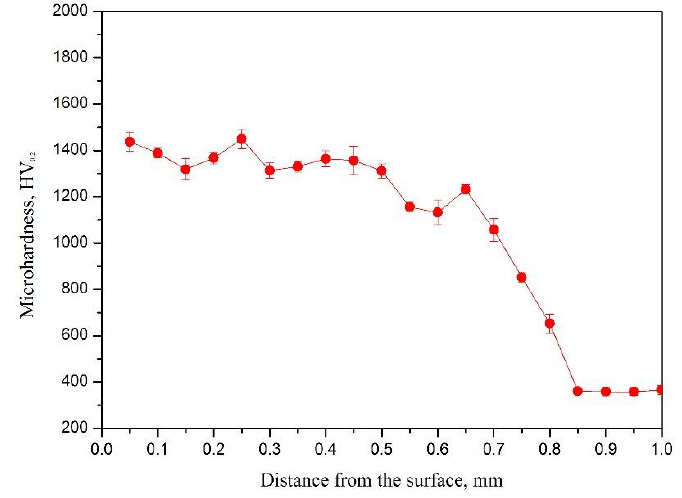
Figure 6. The hardness distribution of the coating.